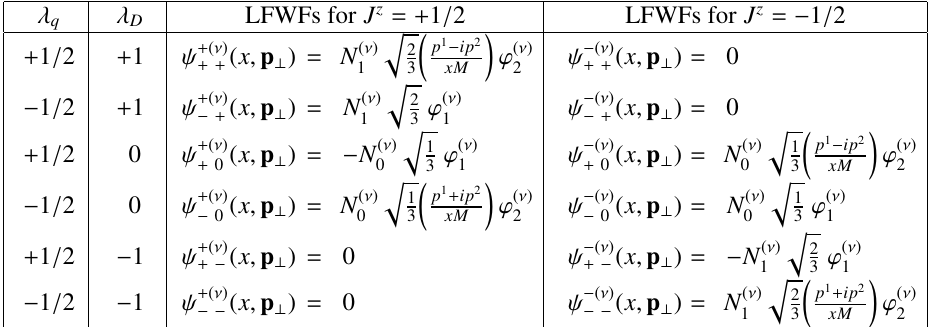
, N ( ν ) are the normalization 0 1